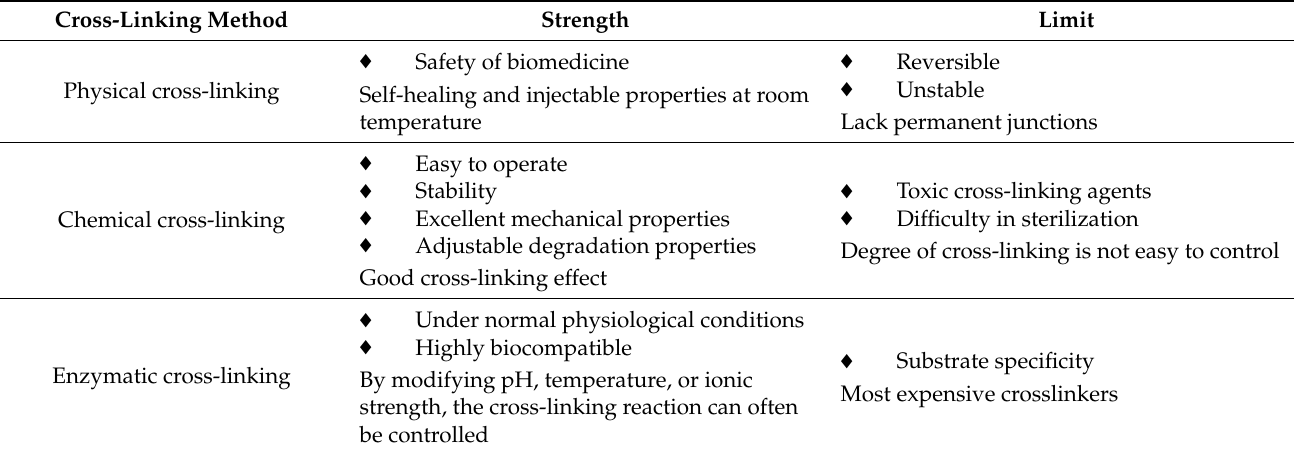
Table 3. Advantages and limitations of modified methods of chitosan.